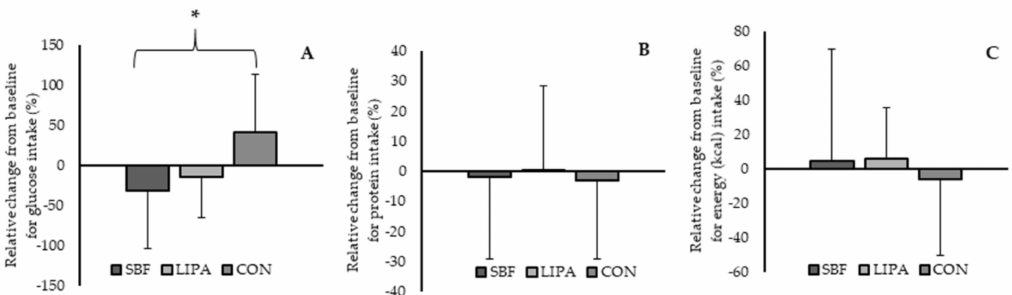
Figure 1. Group-dependent relative changes from baseline for three key nutrients. Panels A, B, and C represent changes in glucose, protein, and energy intake (kcal) respectively. Note: Regarding panel ( A ), glucose exhibited a group × time interaction e ff ect for glucose intake ( p = 0.03), but not a main e ff ect for time ( p = 0.48). Thus, * represents the significant post-hoc di ff erence between the decrease in glucose for SBF, and the increase for control (CON) ( p = 0.01). Regarding panel ( B ), daily protein intake exhibited a main e ff ect of time ( p = 0.004), but not a group × time interaction ( p = 0.59). Regarding panel ( C ), no significant main e ff ect of time nor time × group interaction was observed for energy intake ( p ≥